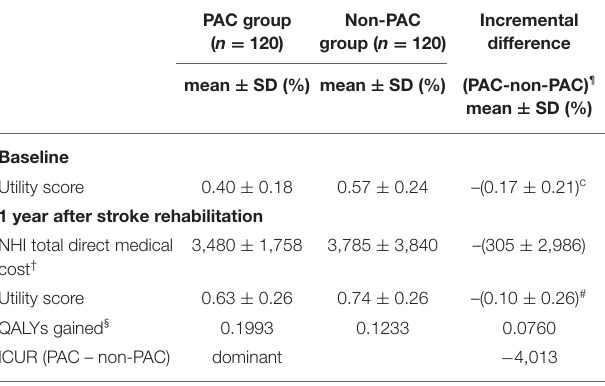
TABLE 3 | Cost-utility analysis of PAC and non-PAC groups within 1 year after stroke rehabilitation